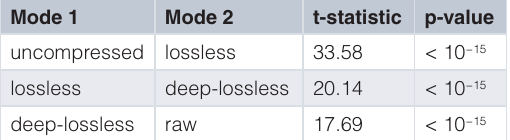
Table 2. Significance of difference in size of files compressed with different methods using a dependent sample